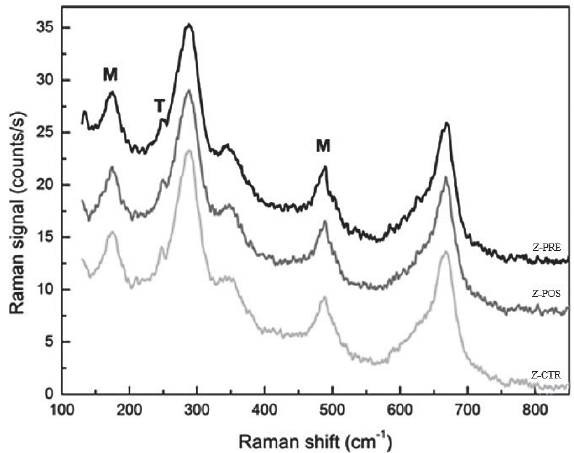
Figure 10- Raman strong peaks for monoclinic (M) and tetragonal (T)